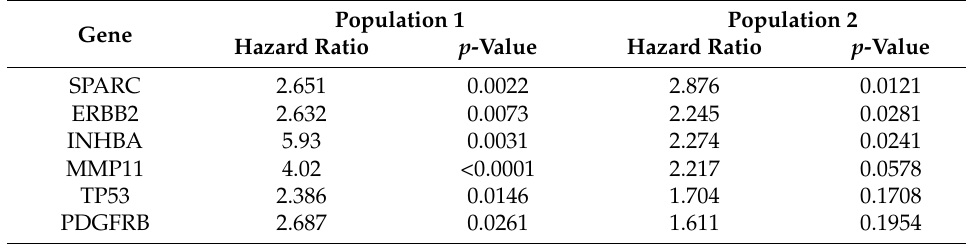
Table 3. The candidate risk stratification markers identified by qPCR analysis.